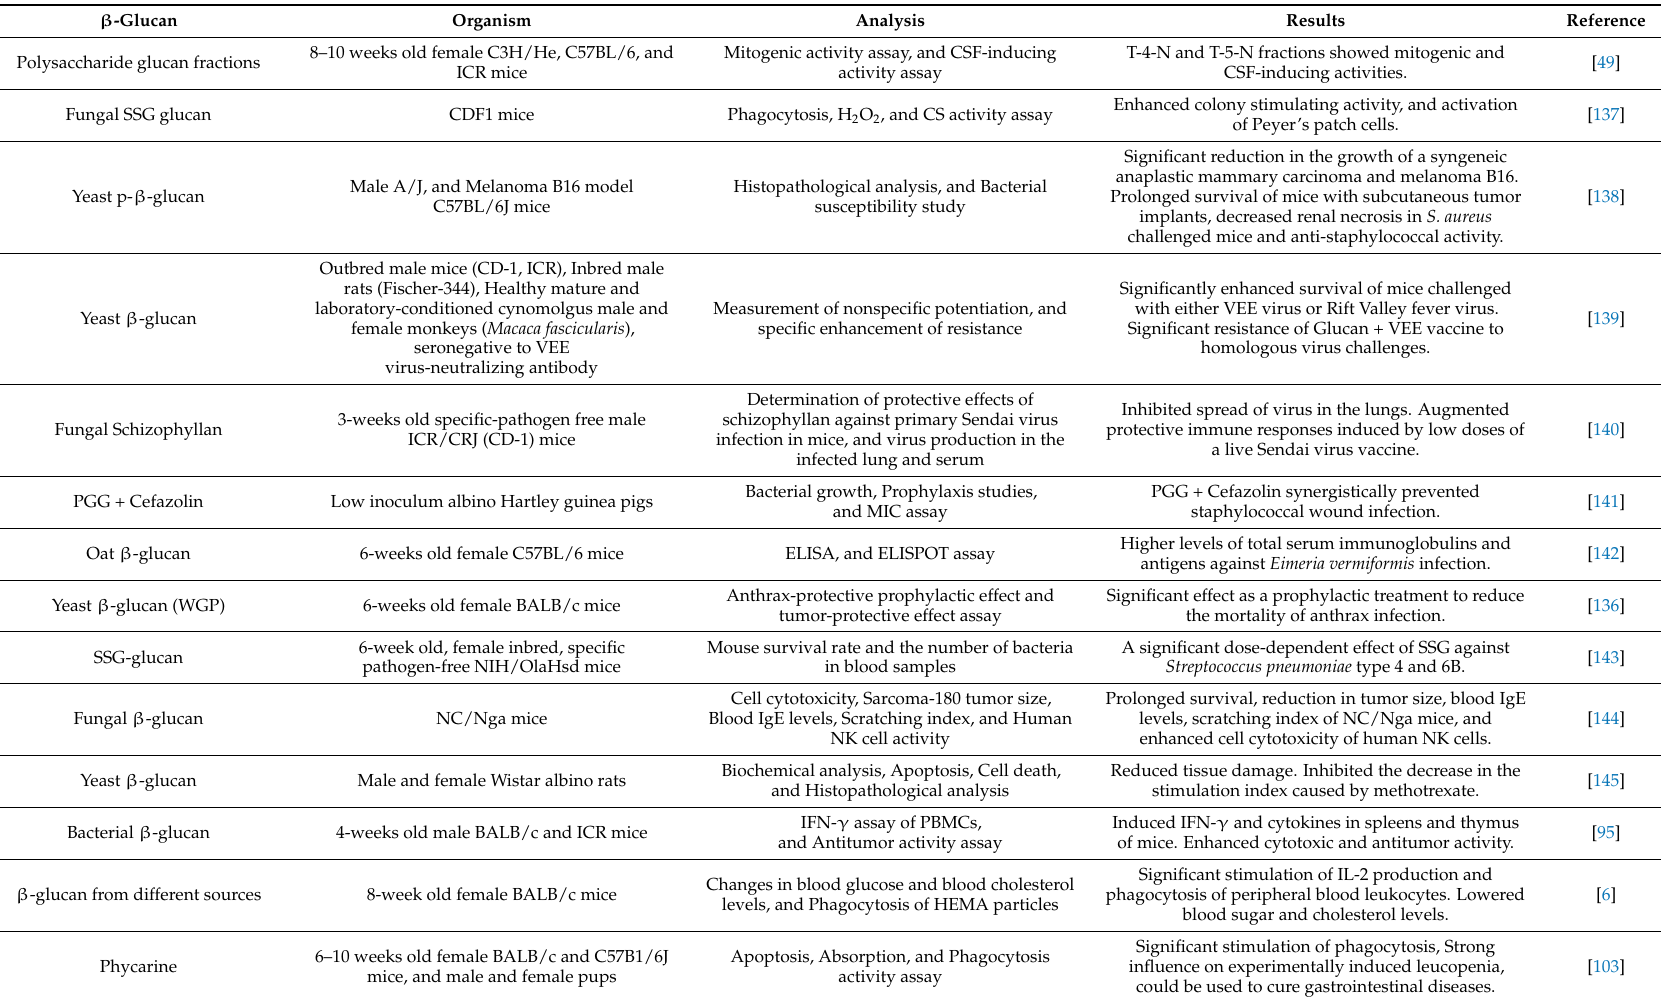
Table 6. Immunomodulating effects of β -glucans—animal